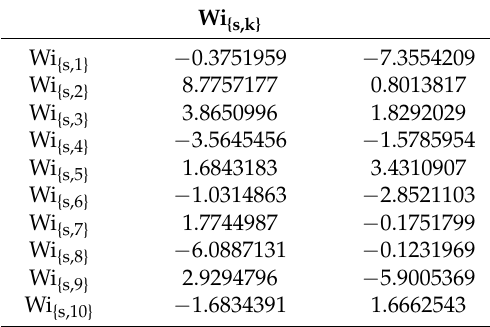
Table A2. Weights and biases for the IP ANN model at birth and during hospitalization (2 neurons in the hidden layer, k = 2 and l =